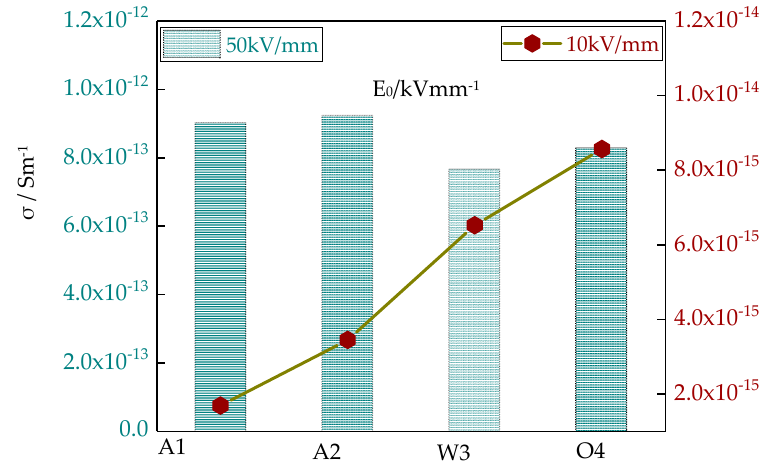
Figure 4. The conductivity line chart and bar chart of different cooling samples under 10kV/mm and 50 kV/mm electric fields.